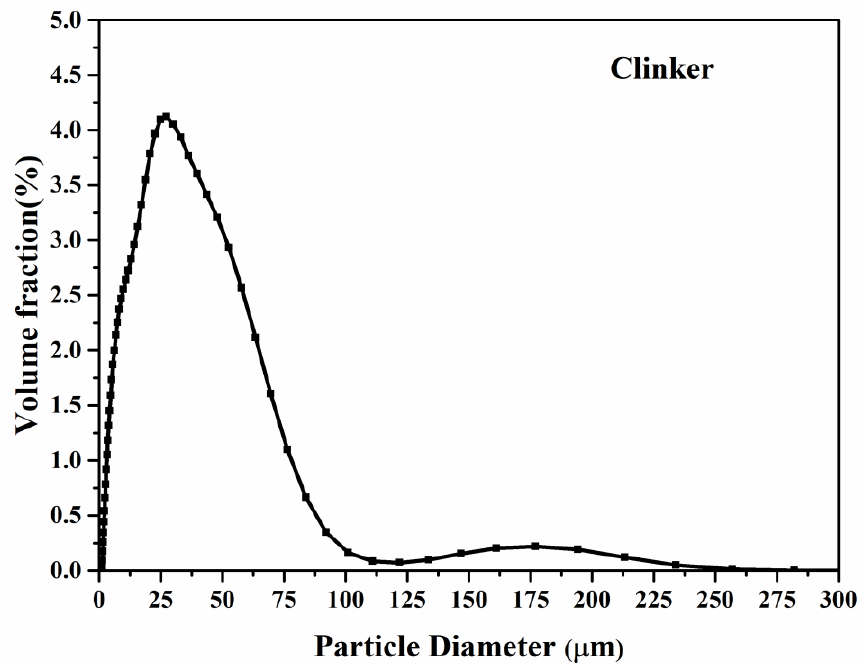
Figure 1. Particle size distribution of used clinker. Table 1. Chemical compositions of used clinker.